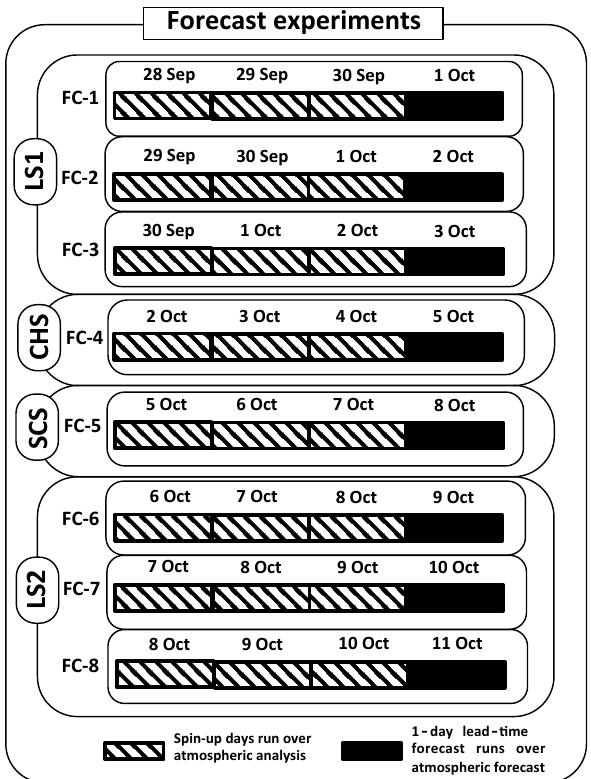
Figure 6. Sketch of forecast experiments performed on the different scales. The 3 days of spin-up define the initial conditions for the 1- day lead-time